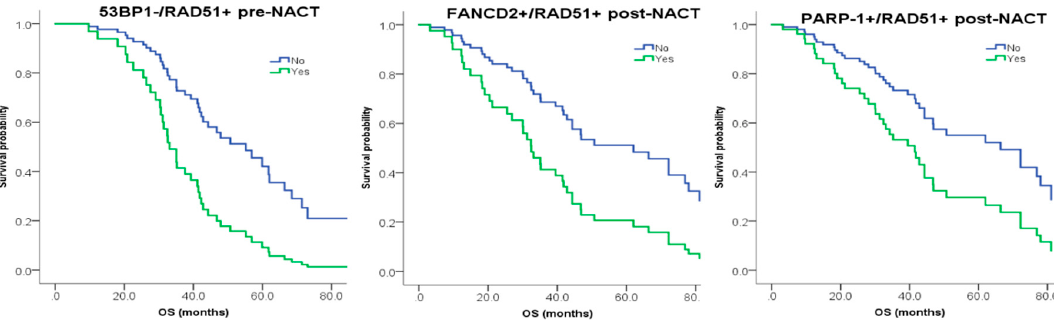
Figure 1. Overall survival of combined DNA repair biomarkers at diagnosis pre-NACT or post-NACT in multivariate analysis.